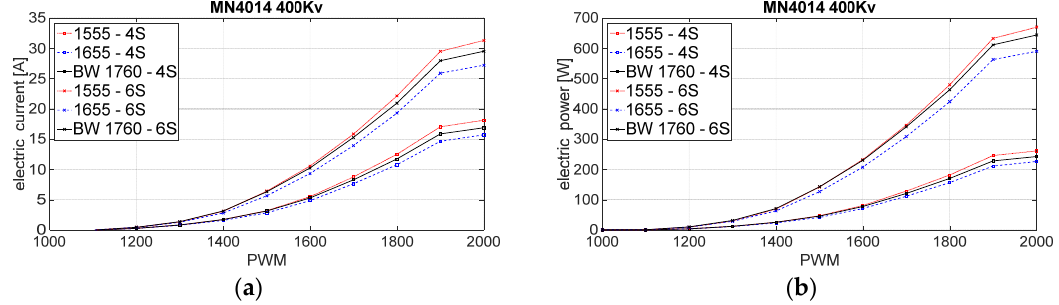
Figure 15. Static maps—MN 4014 BLDC motor: ( a ) electric current; ( b ) electric power.